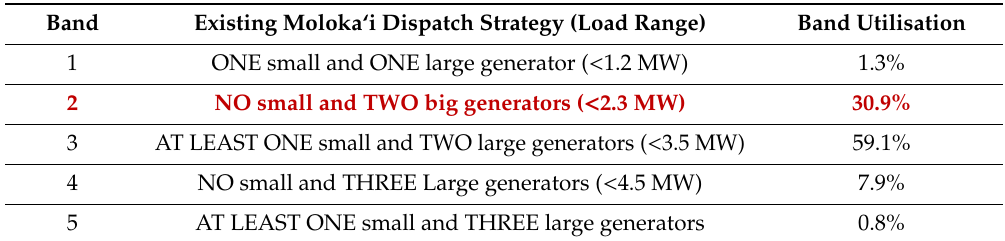
Table 5. Moloka‘i diesel utilisation for a 3 MW solar PV scenario (current dispatch scheme).